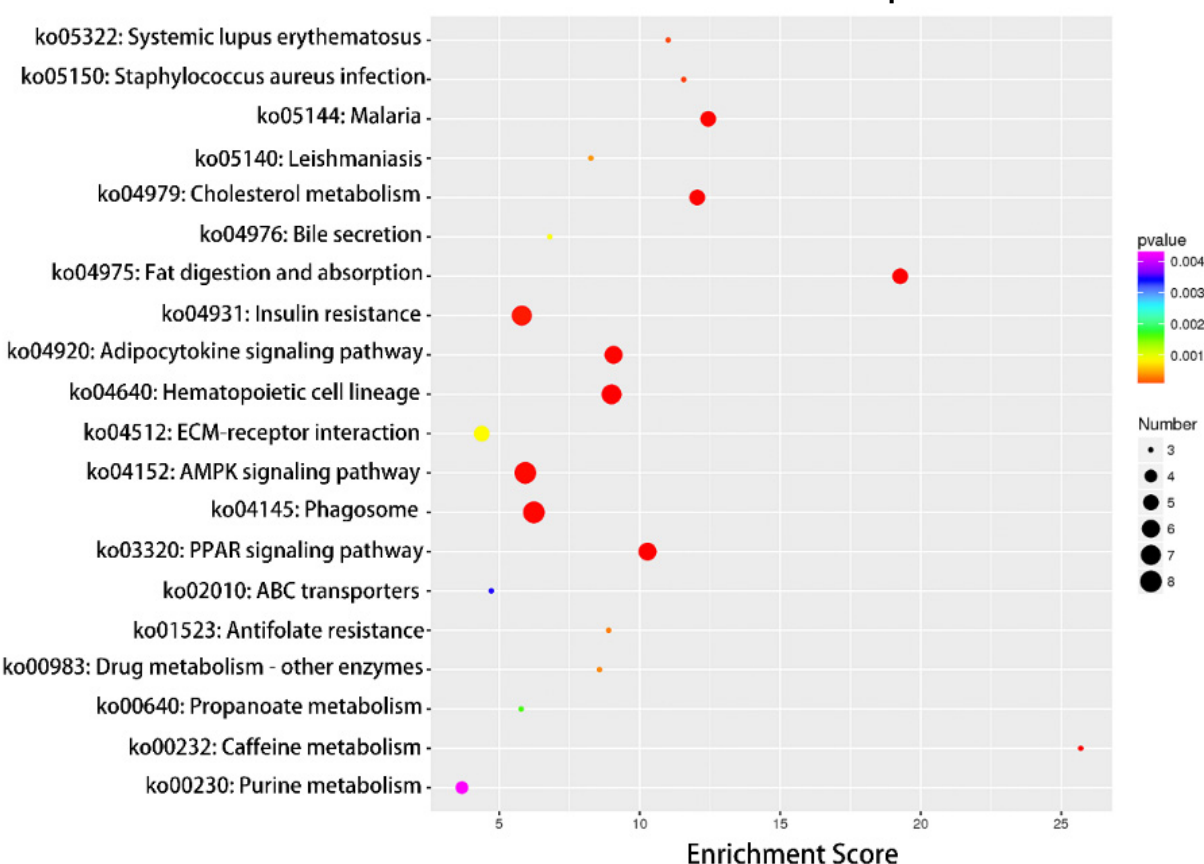
Figure 5. Top 20 categories of KEGG pathway analysis. KEGG enrichment top 20 bubble diagram, where the x -axis is the Enrichment Score. The larger the bubble, the more circRNAs the item contains, and the color of the bubble changes from purple to blue to green to red. The smaller the Enrichment p -value, the greater the significance.